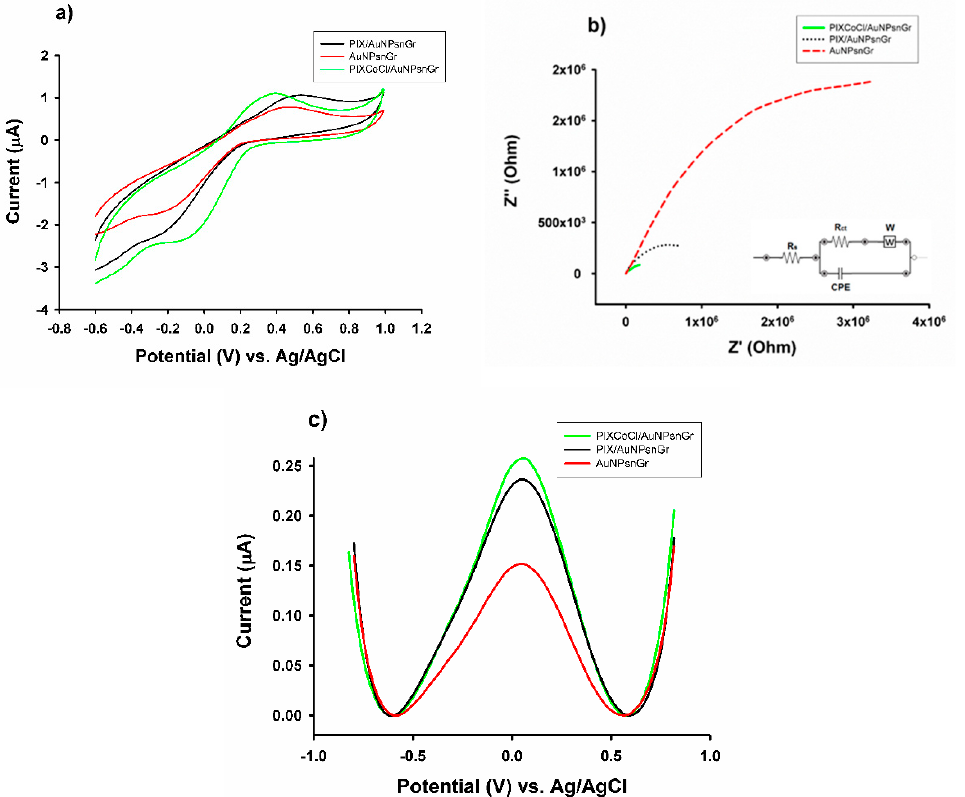
Figure 2. ( a ) CVs of the current versus the potential (working conditions: step potential 0.025 V; scan rate 0.1 V s -1 ) in a 5.0 × 10 − 3 mol L − 1 K 3 [Fe(CN) 6 ] (0.1 mol L -1 KCl) solution employing AuNPsnGr (red line), PIX/AuNPsnGr (dark line), and PIXCoCl/AuNPsnGr (green line); ( b ) EISs recorded for AuNPsnGr (red), PIX/AuNPsnGr (dark), and PIXCoCl/AuNPsnGr (green) in a 5.0 × 10 -3 mol L -1 K 3 [Fe(CN) 6 ] (0.1 mol L − 1 KCl) solution (working conditions: frequency range between 10 5 to 10 -1 Hz). Inset: the equivalent circuit diagram of the electrochemical interface used to fit the EIS where R s is the solution resistance; CPE is the constant phase element; W is the Warburg diffusion resistance; R ct is the electron-transfer resistance; ( c ) DPVs recorded in pH 2.0 PBS containing 0.1 mol L -1 NaNO 3 as supporting electrolyte and 1 − 9 mol L − 1 thiamine for AuNPsnGr (red), PIX/AuNPsnGr (dark), and PIXCoCl/AuNPsnGr (green).